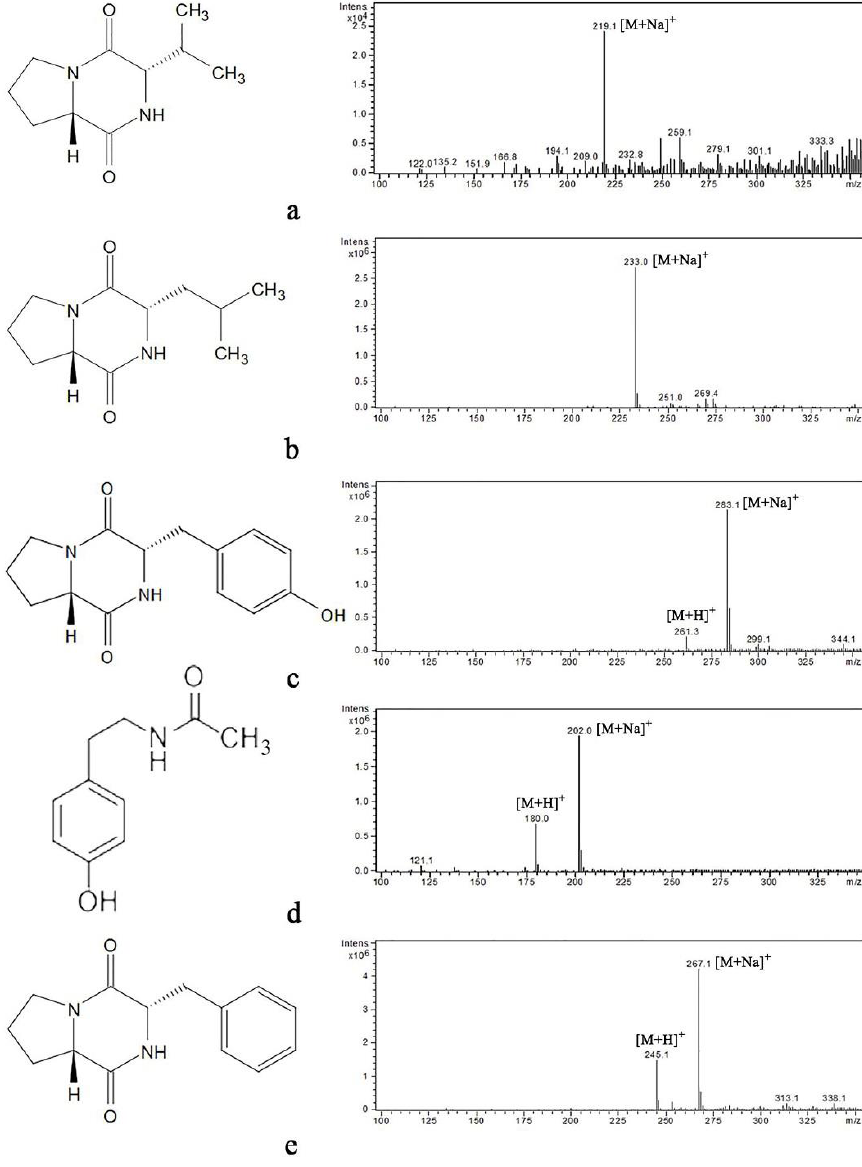
Figure 4. Structural formula and mass spectrum of compounds. ( a – e ) show the structures and mass spectra of compounds 1 to 5, respectively. (M: molecular weight of the compound). Table 1. The MIC of compound 3, compound 5 and